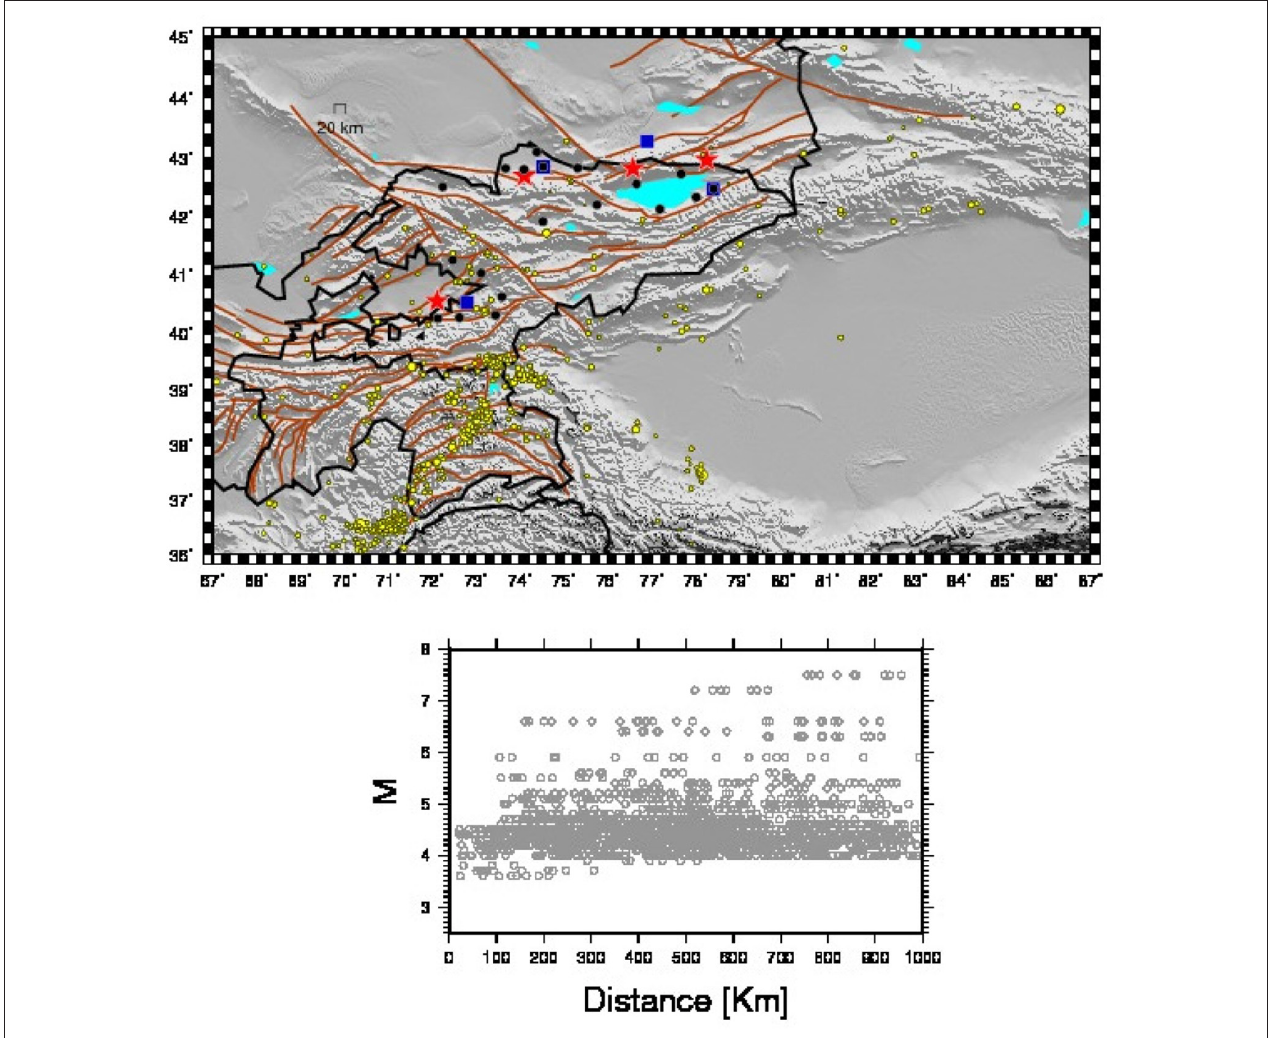
FIGURE 2 | (Top) The locations of the earthquakes recorded by the ACROSS network (yellow circles) since its establishment (May 2015). The red stars and blue squares indicate the positions of a selection of historical events and the main cities of the country, respectively. Black circles indicate the positions of the ACROSS stations. The brown lines indicate some of the main tectonic alignments and faults that have been identified in the region. (Bottom) The distribution of the recorded data in terms of hypocentral distance vs.